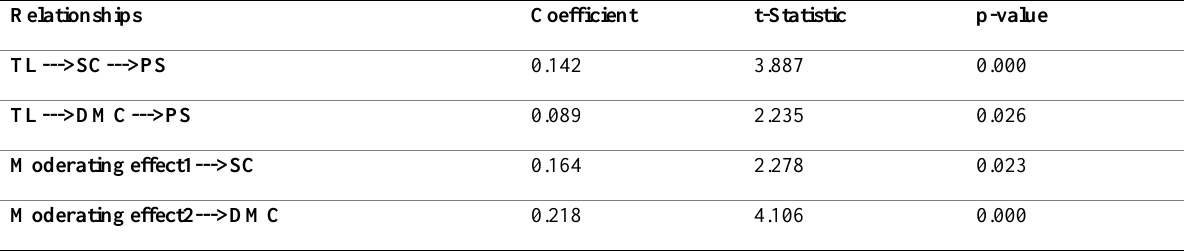
Table 5 : Indirect and moderation